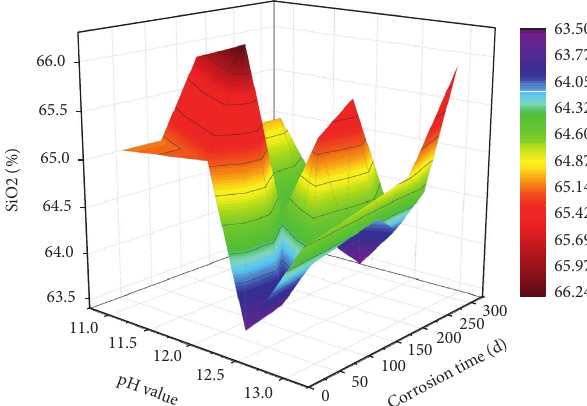
Figure 9: Changes of the SiO 2 content in the laterite at different alkaline-solution concentrations and permeation